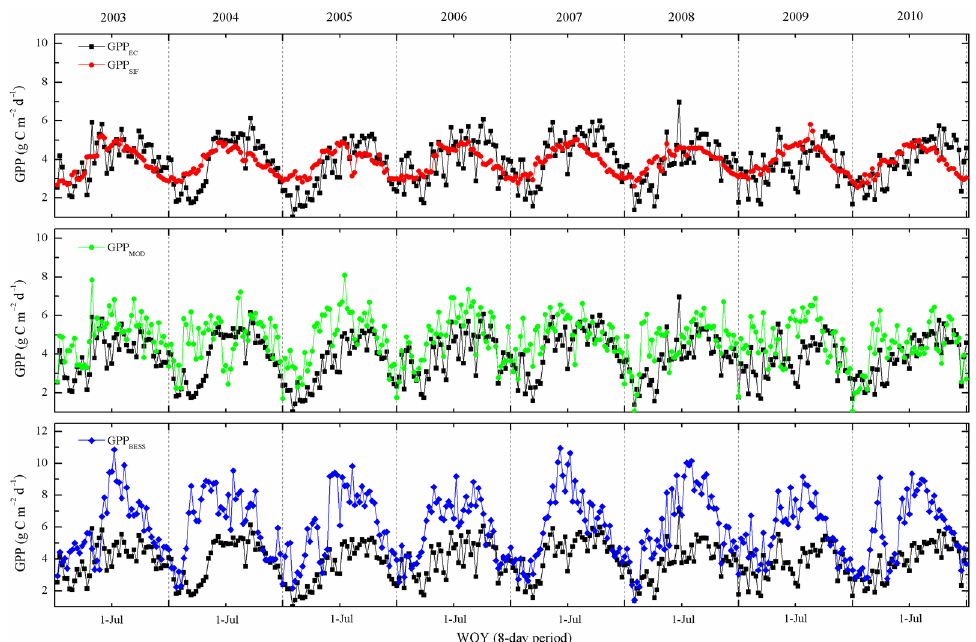
Figure 8. Seasonal consistency between tower-based GPP observations (GPP EC ) at the DHS flux site (evergreen broadleaf forest) and three different satellite-based GPP products including the SIF-based GPP (GPP SIF ), MODIS GPP (GPP MOD ), and BESS GPP (GPP BESS ), respectively.